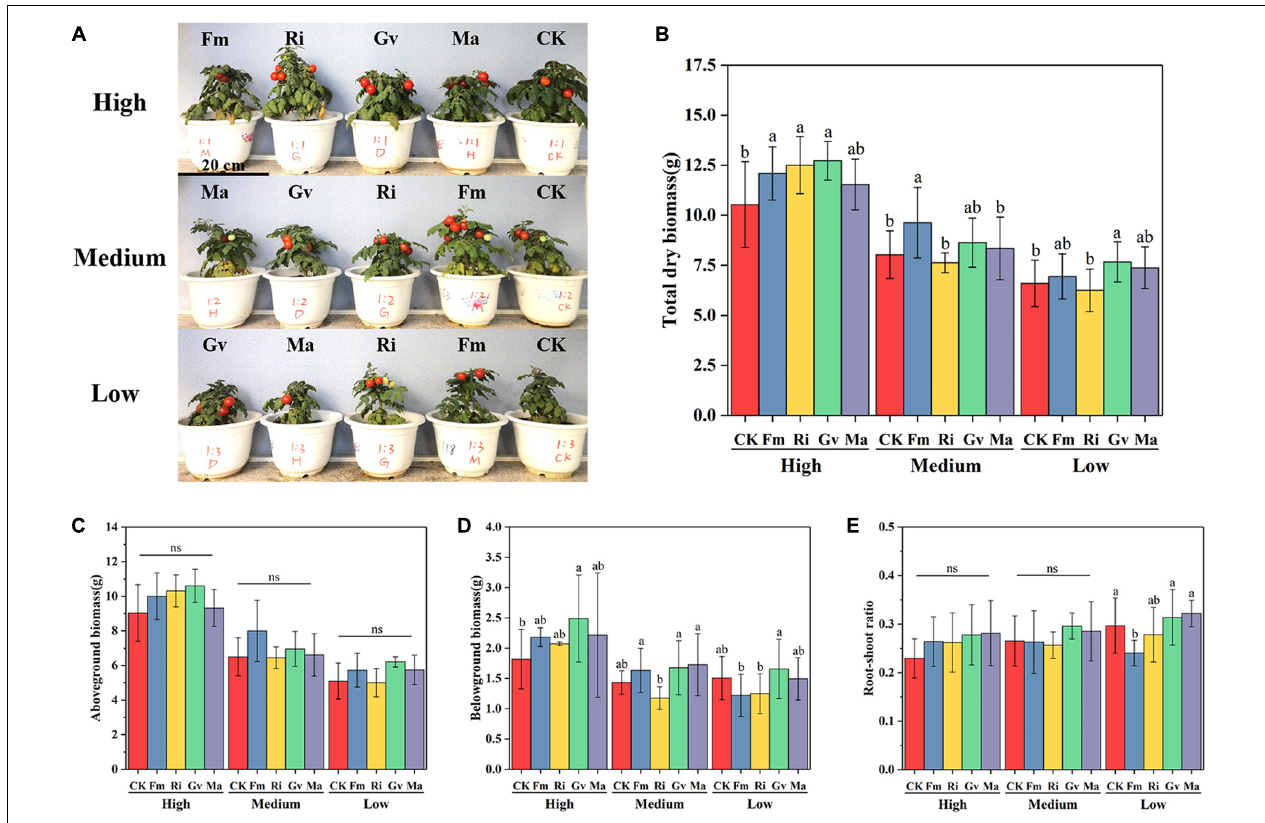
FIGURE 2 | Growth (A) , total biomass (B) , aboveground biomass (C) , belowground biomass (D) , and root shoot ratio (E) of cherry tomato inoculated with different AMF treatments under different nutrient levels. ns denotes no significant difference between AMF inoculation treatments at the same nutrient level ( P > 0.05), the same as